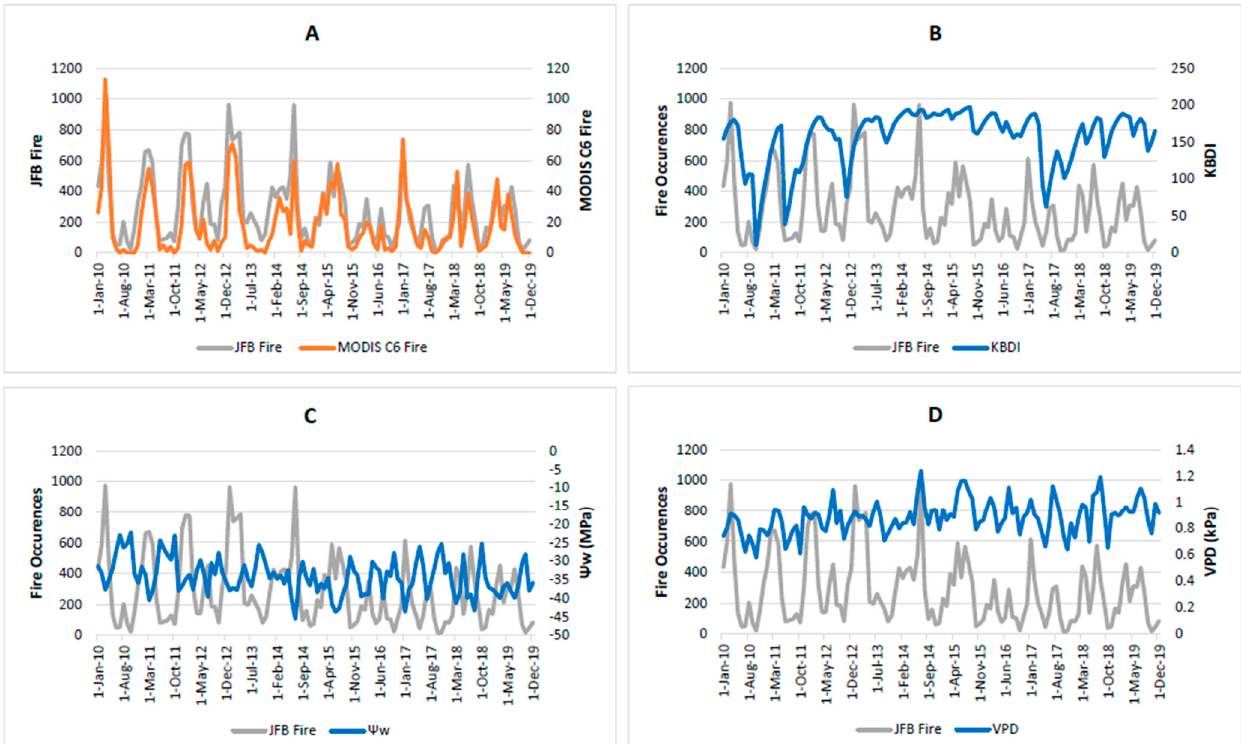
Figure 5. Monthly variation of VPD, KBDI, Ψ w , MODIS and JFB observations for 2010–2019: ( A ) MODIS vs JFB, ( B ) JFB vs KBDI, ( C ) JFB vs Ψ w and ( D ) JFB vs VPD. Bushfire potential indices are derived using ERA5 data.